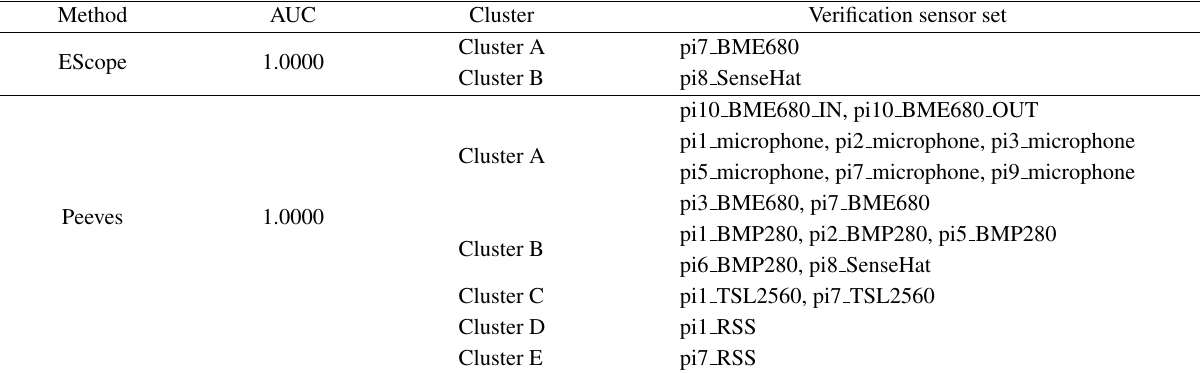
Table 4 Door opened verification sensor sets.